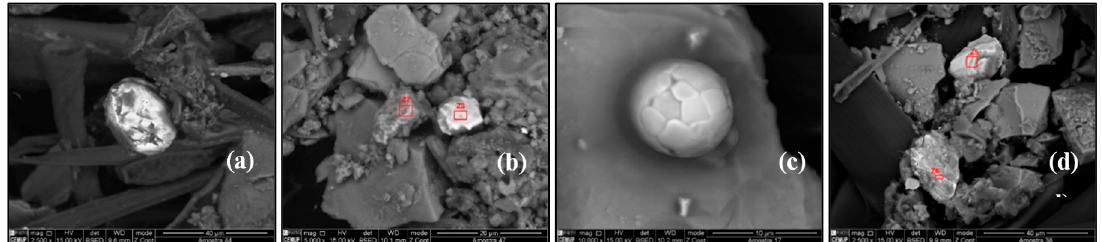
Figure 10. Scanning electron microscopy images of ( a ) monazite particles, ( b ) xenotime particles, ( c ) pure copper sphere 10 µm, and ( d ) pyrite.